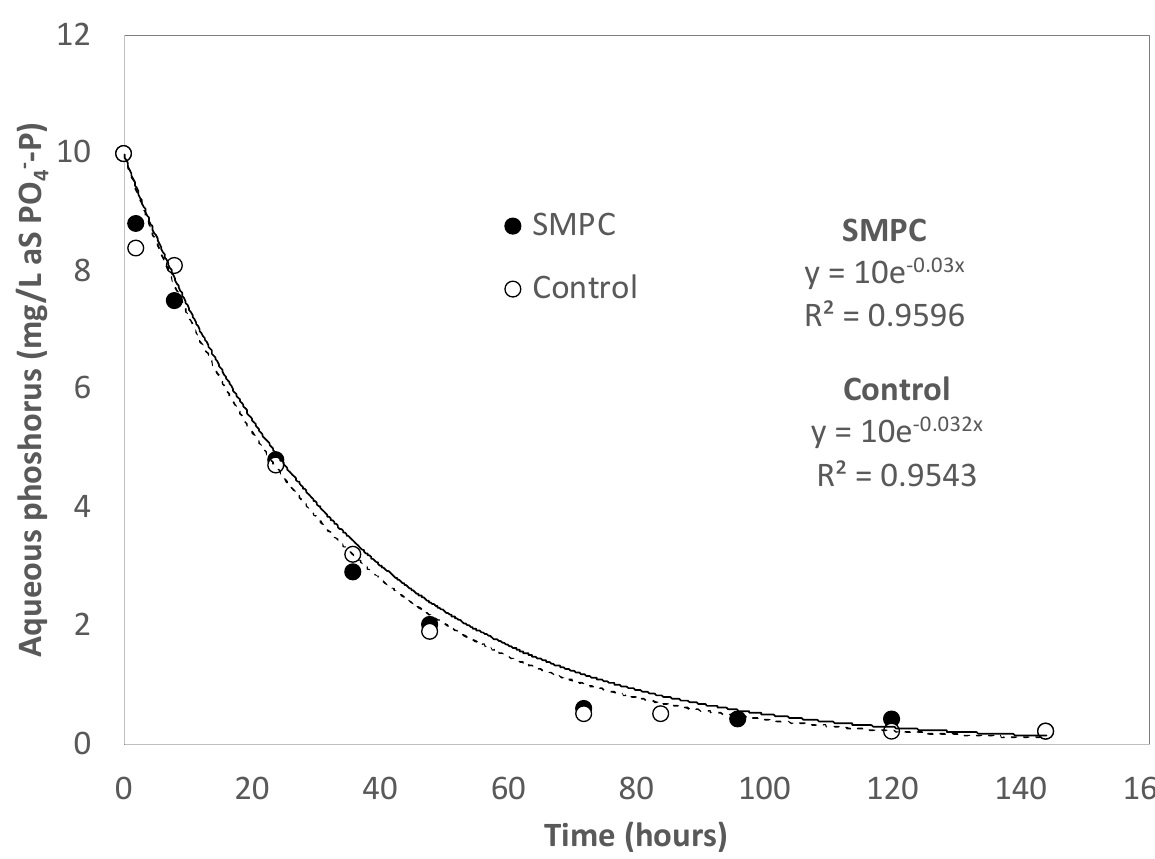
Figure 3. The rate of aqueous phosphorus removal by pervious concrete.